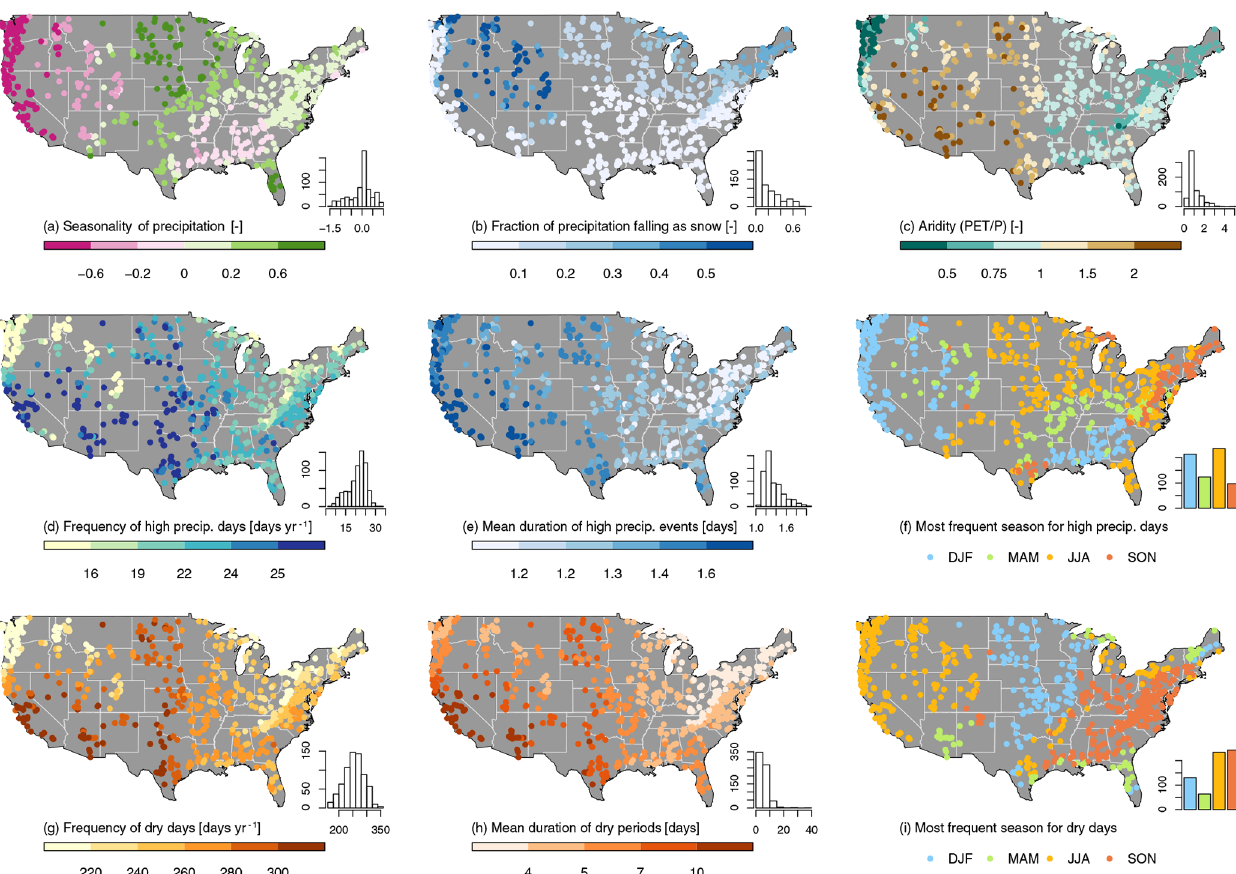
Figure 3. Maps of climatic indices over the CONUS. The histograms and bar plots indicate the number of catchments (out of 671) in each bin or